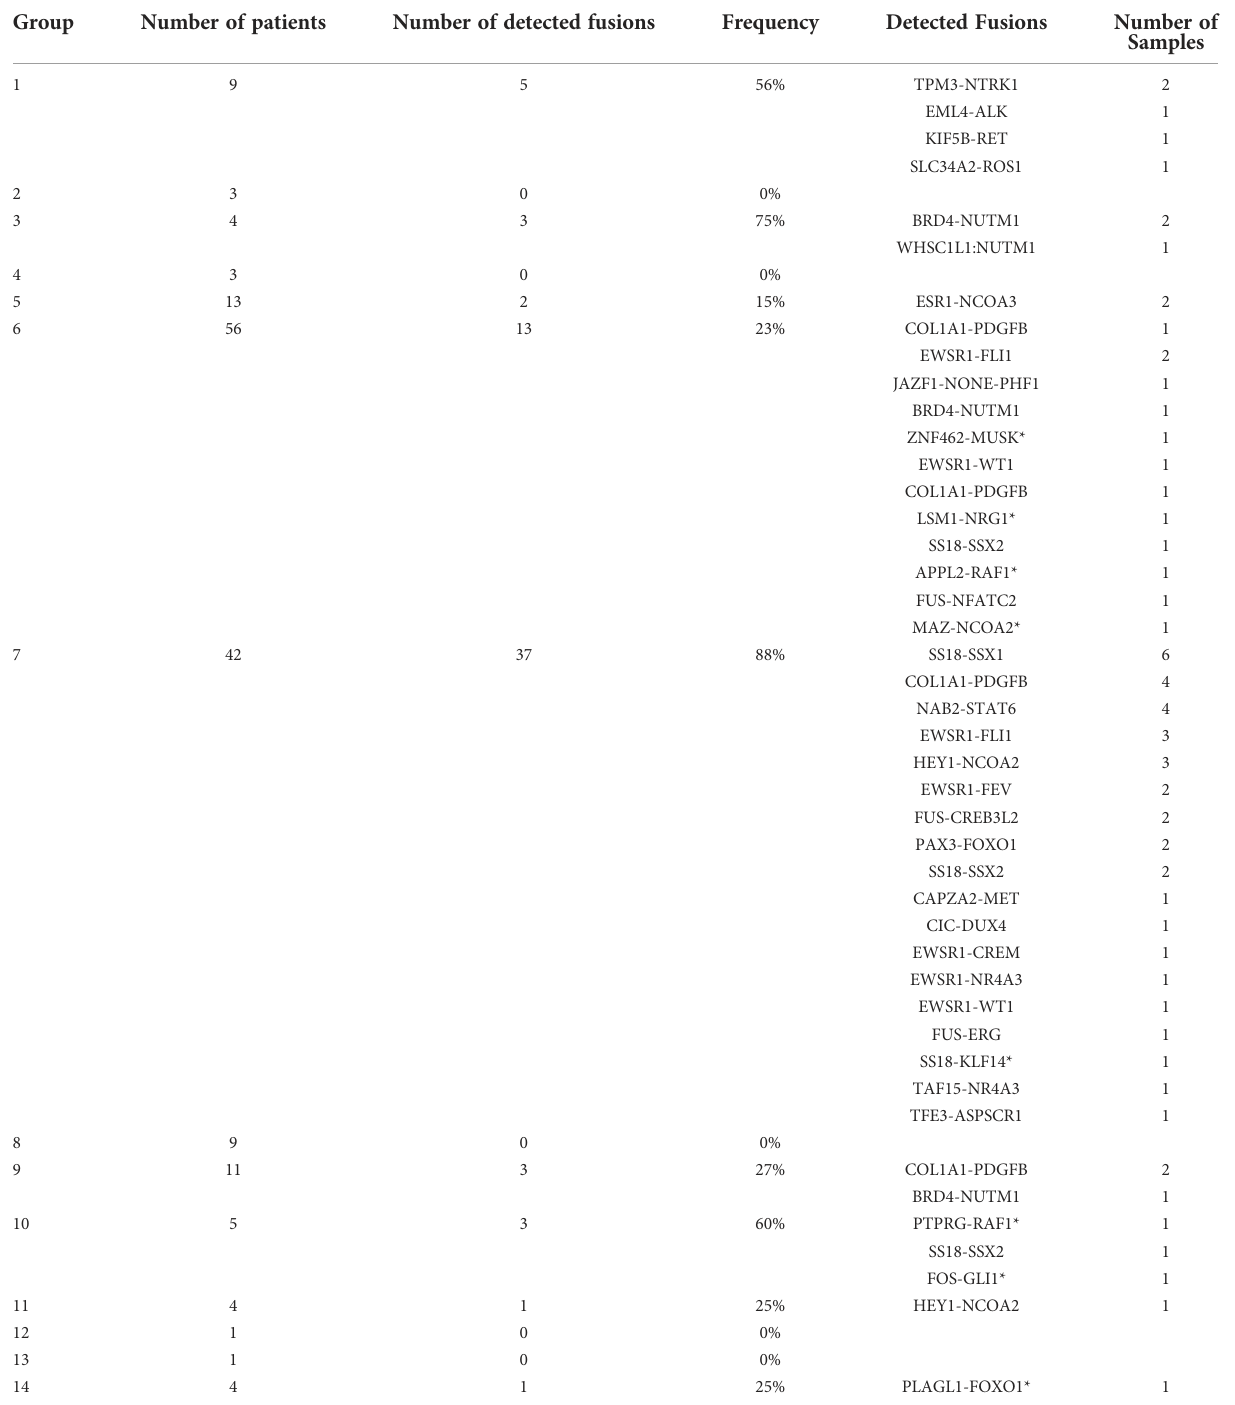
TABLE 1 Detection of fusions according to pathologic classi fi cation.